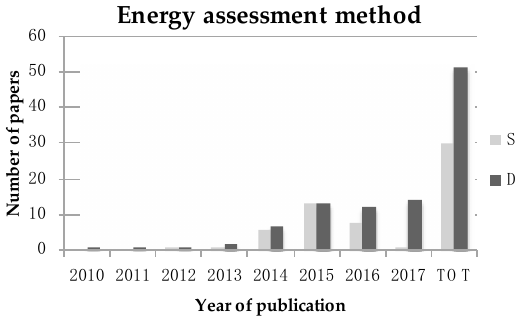
Figure 12. Methods for energy performance calculation: simplified (S) vs. dynamic (D). Evolution of number of papers using the two approaches in the studied period (2010–2017).